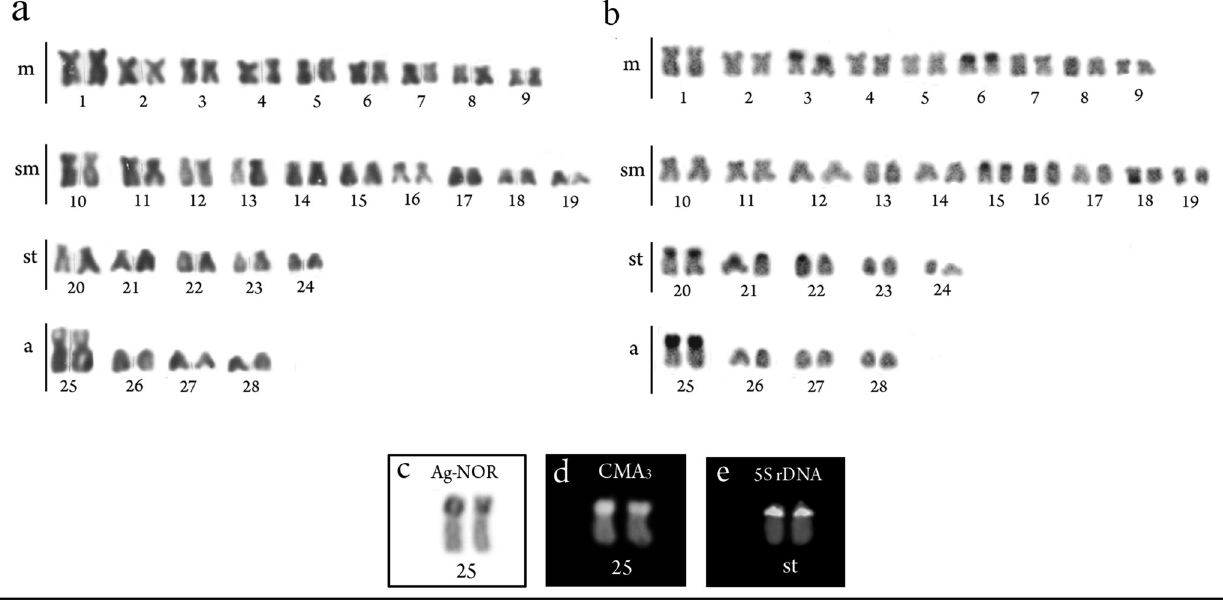
Fig. 2. Karyotypes of S. doceanum : a. Giemsa staining; b. C-banding pattern characterized by the many heterochromatin blocks in different positions. In the boxes chromosome pairs of S. doceanum : c. Ag-NOR sites; d. CMA3 staining; e. FISH with 5S DNAr